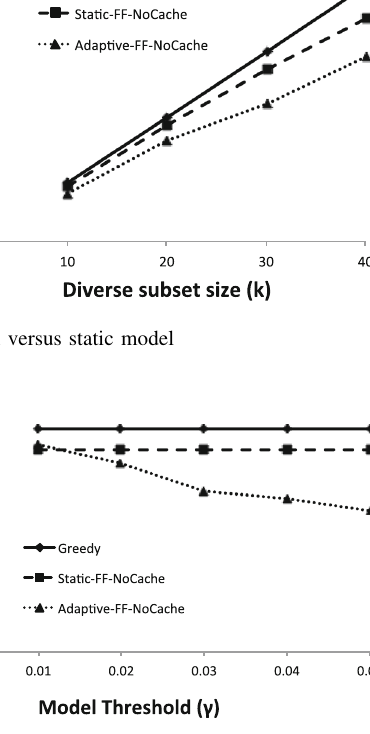
Fig. 9 Impact of c on cost and diversity